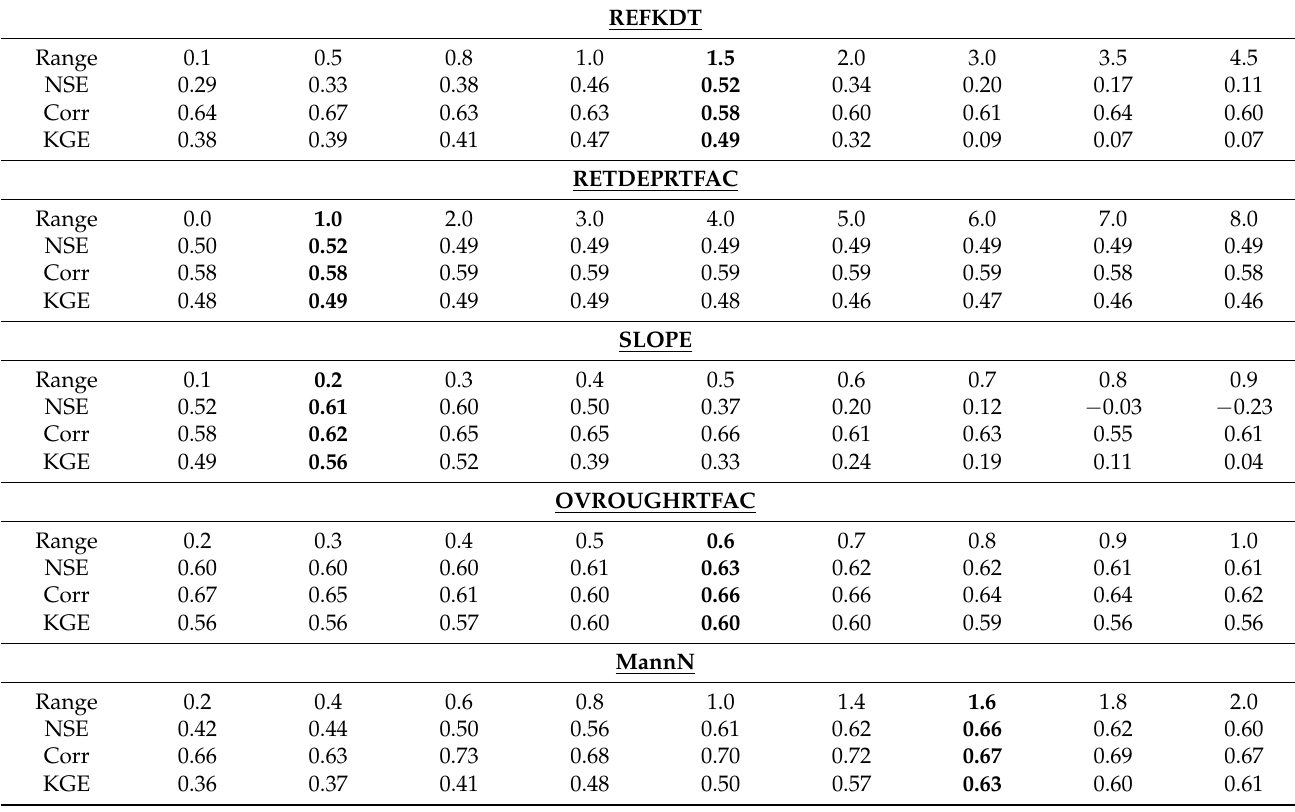
Table 2. Validation of the performance of simulated WRF-Hydro and observed discharge at Sav è , with parameters such as the infiltration-runoff parameter REFKDT, the retention factor RETDEPRTFAC, the SLOPE, the overland flow roughness scaling factor OVROUGHTFAC, and the Manning’s roughness coefficients, MannN. Experiments in bold show the optimum parameters based on the objective criteria (Corr, NSE, and KGE).